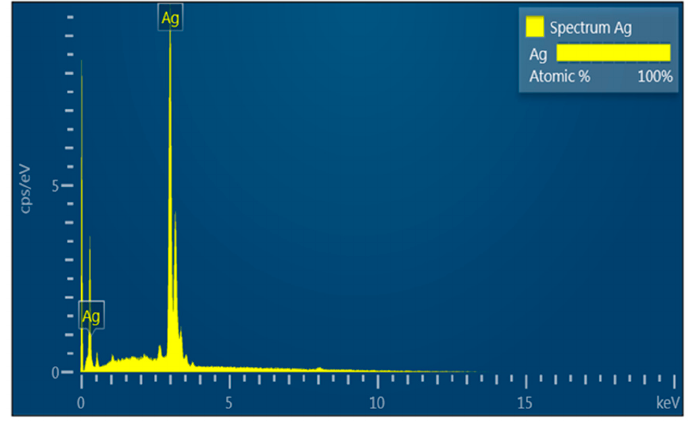
Figure 3. Energy dispersive spectra of a solution of AgNPs deposited on a copper grid.